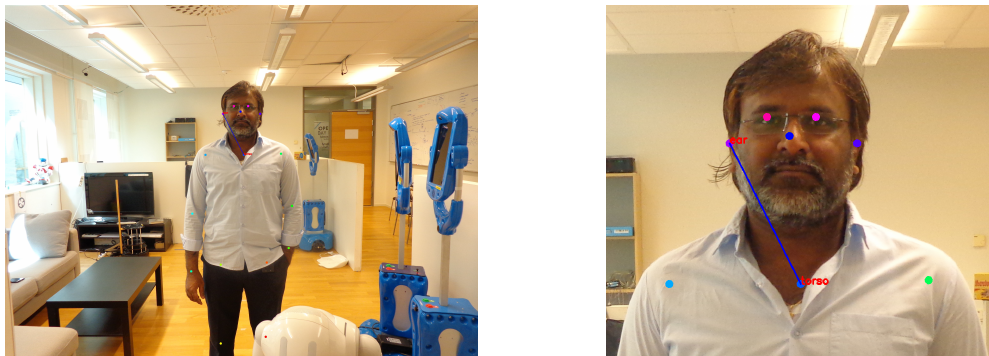
Figure 3. The characteristic points using the method reported in [25]. The left image presents all the characteristic points with colored dots. The right image is the close-up of the corresponding image. The image presents the ear and torso points connected through a